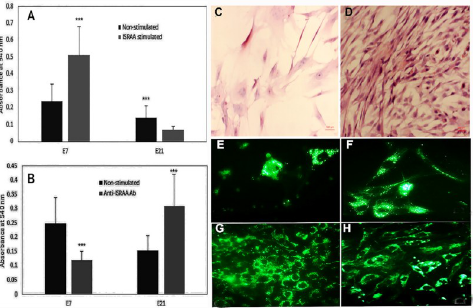
Fig 2. Embryonic brain astrocyte proliferation and differentiation and illustration of ISRAA activity on these events. Spontaneous and ISRAA induced cell proliferation and differentiation were assessed by MTT and by morphological observation and determination. Astrocytes were prepared and cultured as described in the Materials and Methods section. Non-stimulated astrocytes from E7 showed high proliferation (Fig 2A; black bar) and no clear differentiation (represented in Fig 2E). E21 astrocytes showed lower proliferation (Fig 2A; black bar) with clear cell differentiation (represented in Fig 2F). Stimulation of E7 with recombinant ISRAA resulted in increased cellular proliferation (Fig 2A; grey bar) and also represented in Fig 2G. In response to ISRAA stimulation, E21 showed less proliferation (Fig 2A; grey bar) and well differentiated cells (represented in Fig 2H). Pre-incubation with anti-ISRAA antibody abrogated the proliferative response in E7 and induced E21 to proliferate (Fig 2B). Intrinsic ISRAA expression in embryonic mouse brain astrocytes was illustrated by immunohistochemistry. As exemplified in Fig 2C, E7 demonstrates few faint cells stained for ISRAA, while E21 showed high numbers of positively and strongly stained cells for ISRAA (exemplified in Fig 2D). Experiments were conducted twice with alike findings. Pictures were gathered via bright field microscopy (x630). Bars denote the means ± SD of eight cultures ( ��� p <